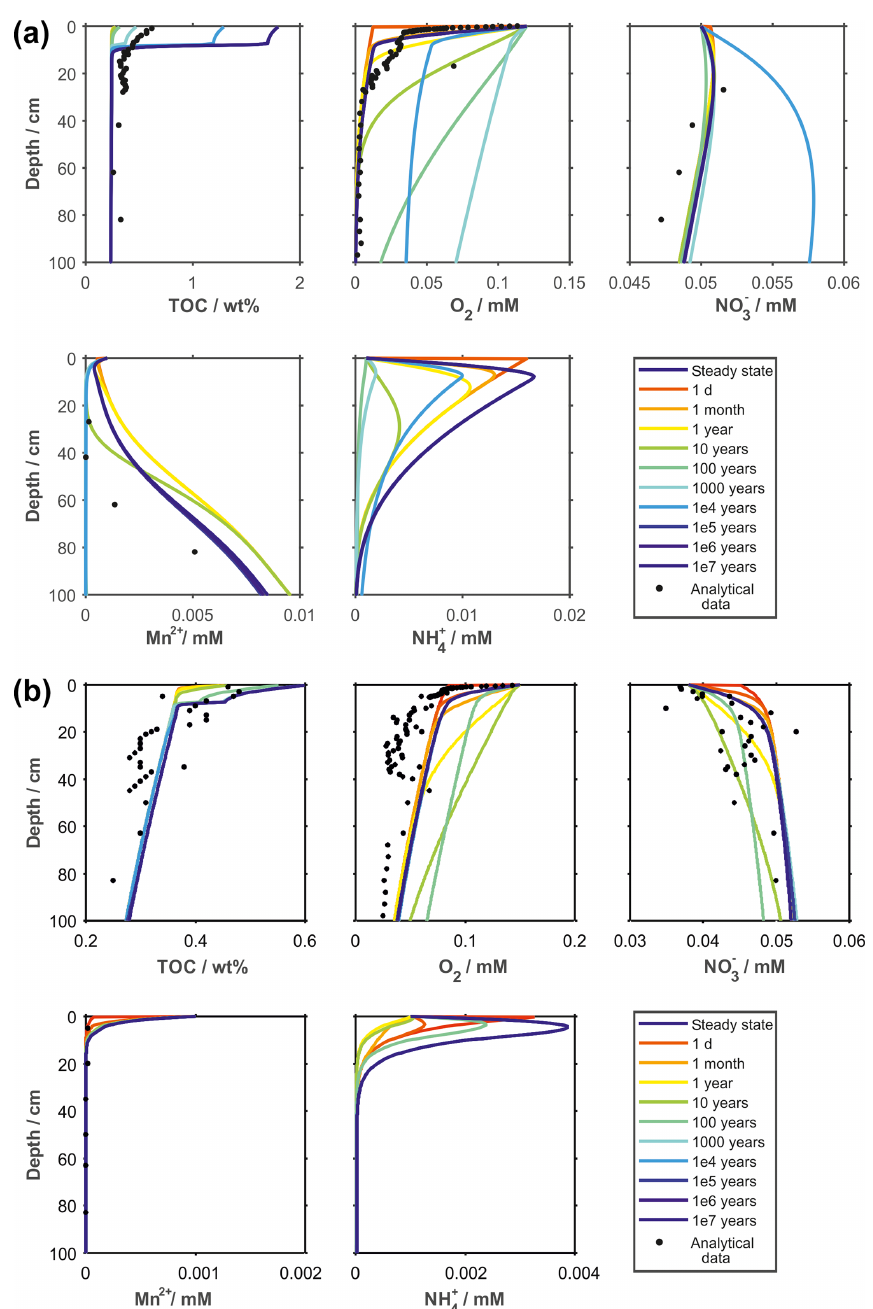
Figure 6. Detailed model results of the transient transport-reaction model (Fig. 5) showing depth profiles of TOC, O 2 , NO − NH + for the upper 1m of the sediments with the fit of the simulated profiles with the analytical data for undisturbed sediments at current 4 steady-state geochemical conditions and for the new steady-state geochemical system after the disturbance (dark blue profiles) for (a) EBS disturbance in the German BGR-RA area and (b) the IOM-BIE disturbance in the eastern European IOM